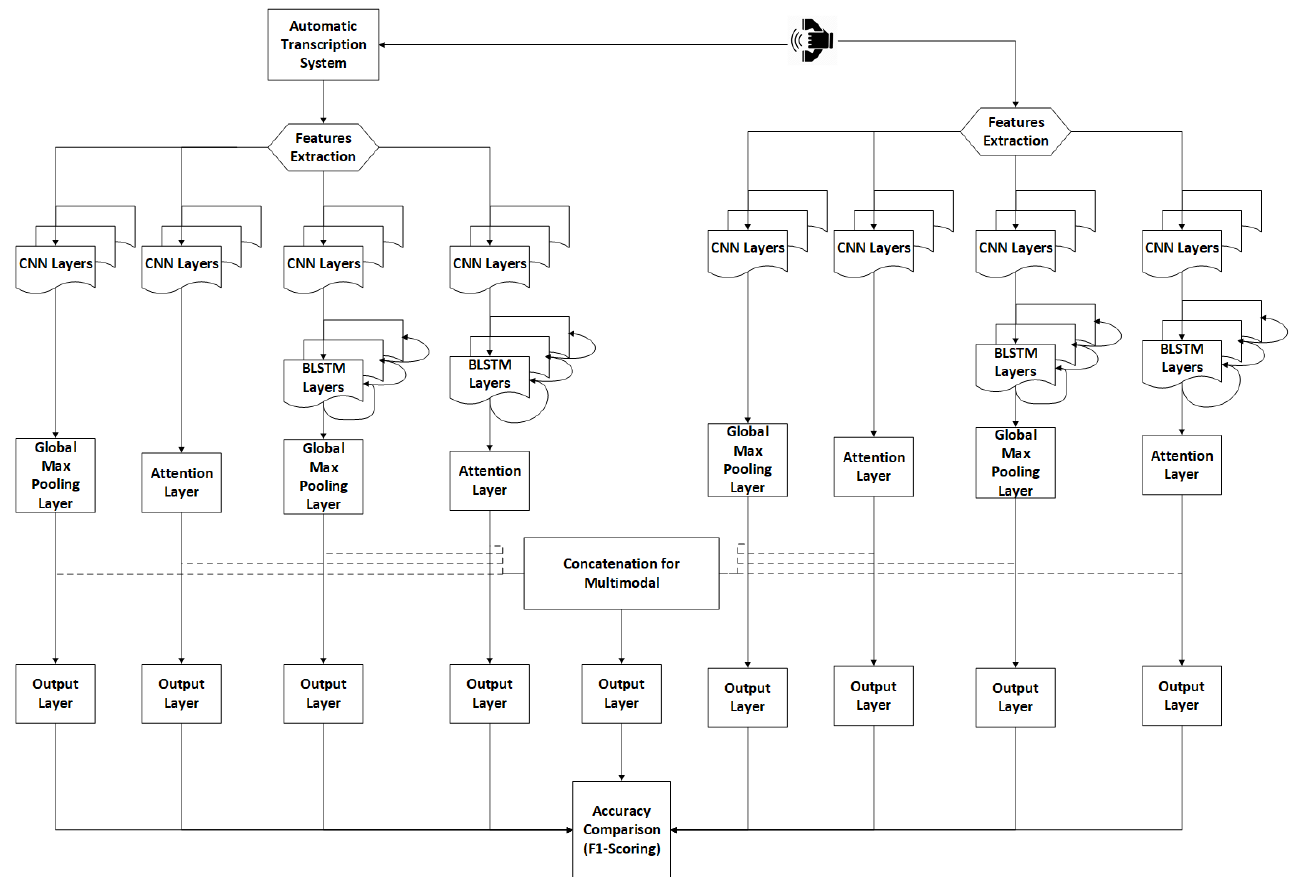
Figure 1. The proposed framework illustrates two schemes for speech and text. The dotted lines indicate the multimodal approach for merging one path for each scheme and forward it to the output